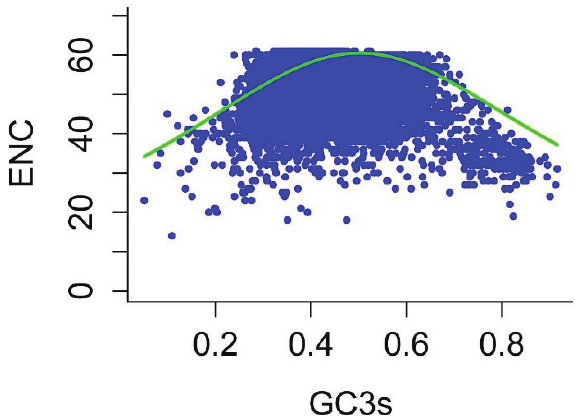
Figure 3. Relationship between GC3 and the effective number of codons (ENC) (ENC plot). ENC is plotted against GC content at the third codon position. The expected ENC from GC3 is shown as a standard